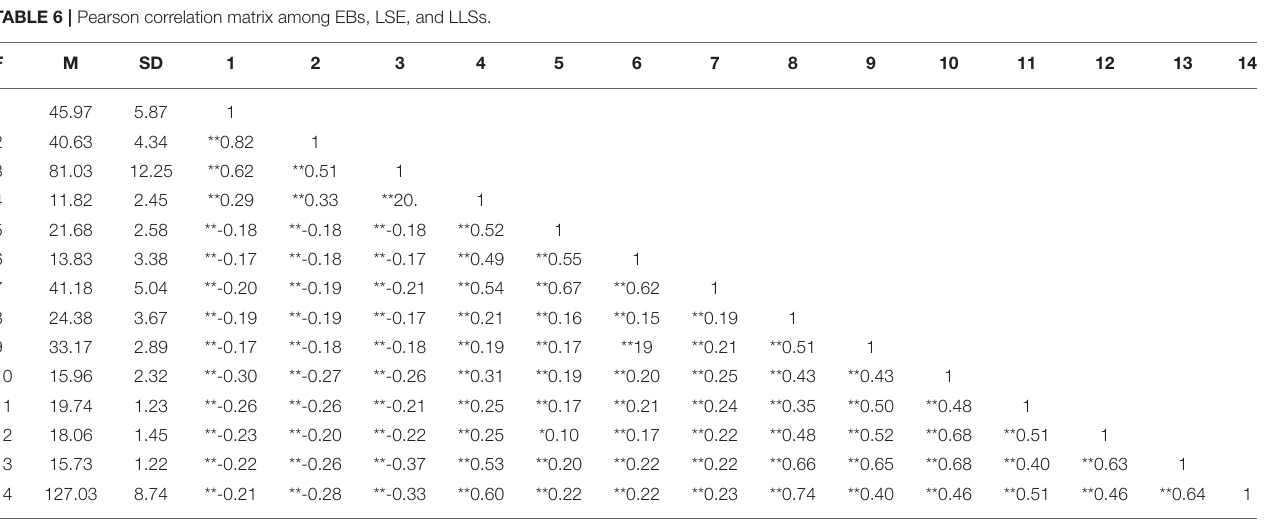
TABLE 6 | Pearson correlation matrix among EBs, LSE, and